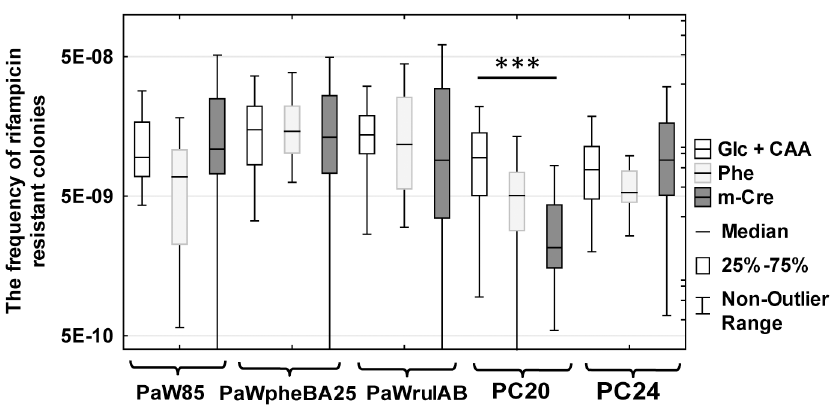
Fig 7. Study of the effect of phenolic compounds on the frequency of Rif r mutants in nutritiously rich growth medium. Phenolor m -cresolwas supplemented into M9 glucosemedium supplemented with CAA for the strains PaW85, PaWpheBA, PaWrulAB and PC24 at the followingconcentrations: phenol(5 mM), m - cresol (2.5 mM). These compounds were added in lower concentrations (2.5 mM phenoland 1.25 mM m - cresol) for the strain PC20 becauseof growth inhibitingeffects at higherconcentrations. Data were analysed using the Kruskal-Wallis test (S10 Table). *** designates P < 0.0001.